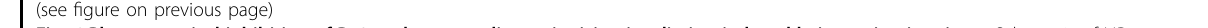
Fig. 6 Pharmaceutical inhibition of P53 pathway ameliorate ionizing irradiation-induced hair graying in mice. a Schematic of LIR treatment and drug administration. Orange: IR area. PFT α was topically applied daily right after IR for 5 times. Skin samples were collected at 2 weeks post depilation (A1) and photos were taken at 4 weeks post depilation (A2). b Backskin images of Rad skin areas of Sol or PFT α treated LIR mice A2 time. c Quanti fi cation of white hair % of the b fi gure skin area. n = 9 sites from 3 mice. d Left: Representative ( n = 3) IF images of mouse HFs matrix region at A1 time. Scale bars: 50 μ m. Right: Quanti fi cation of positive cell% for each of the indicated staining markers in the HF matrix. Numbers were fold change vs noRad + Sol. all P values were from two-tail t -test and all error bars represent standard errors. e Heatmap summarizing pre-ranked GSEA analysis results. Input gene sets: signi fi cantly up-regulated (UP) or down-regulated (DN) genes in each cell group for white-vs-black (W-vs-B) comparisons of F62 (F62W-vs-F62B) and F31 (F31W-vs-F31B). Ranked lists of genes (Rnk) were produced using gene expression fold change of (Rad + PFT α skin epithelium) vs (Rad + Sol skin epithelium) as described in the d fi gure. Red indicated enrichment while blue indicated depletion. NES: normalized enrichment score. * P < 0.05. f , g Left: Representative ( n = 3) IF images of LIR mice ’ s HF upper ORS region around bulge (UPORS) and matrix region(MX). Samples were collected at day 5 ( f ) and day14 ( g ) post the LIR waxing. Right: Quanti fi cation of DCT positive cell (arrows) number in UPORS and MX regions as indicated. Scale bars: 50 μ